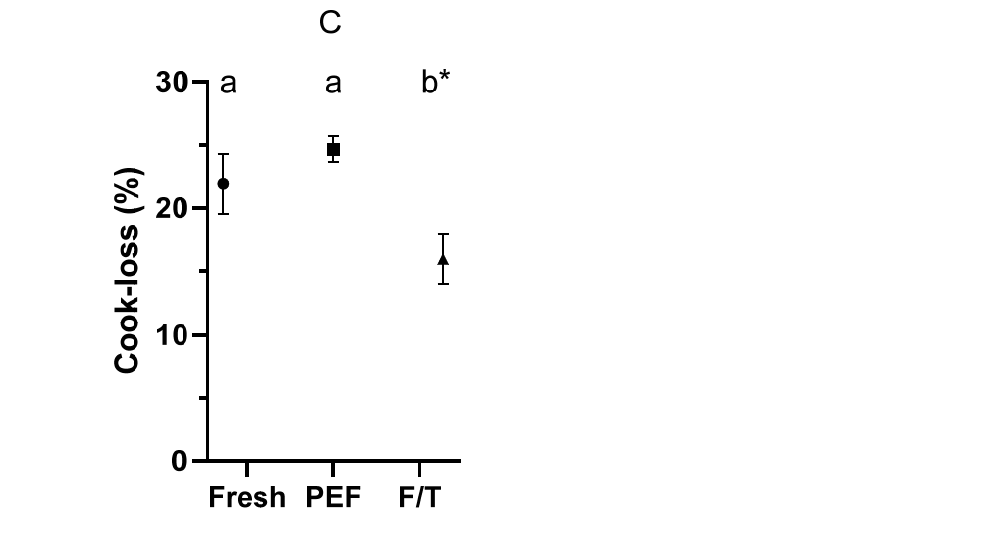
Figure 5. Moisture ( A ), water holding capacity ( B ), and cooking loss ( C ) of control ( ● ), PEF-treated (3 kV/cm, 50 kJ/kg, and 30 µs) ( ■ ), and frozen/thawed (F/T) hake fillet samples ( ▲ ). Different letters indicate statistically significant differences among treatments ( p = 0.05). The * indicates the statistical significance of the differences: * ( p < 0.05); ** ( p < 0.01); *** ( p < 0.001).